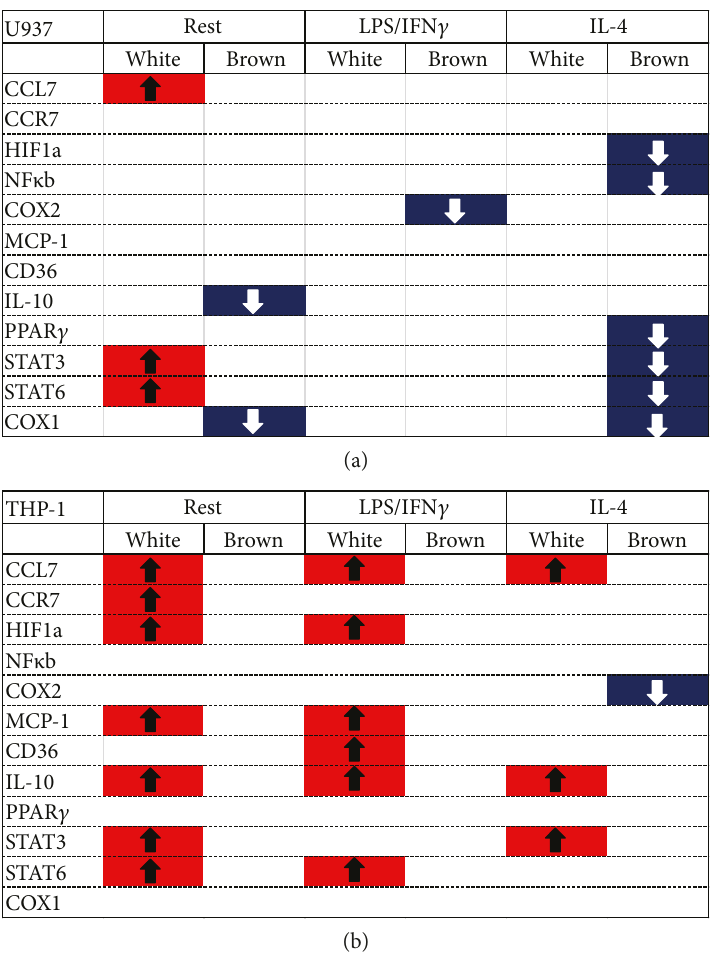
Figure 4: Summary of statistical analysis of transcript expression in macrophages . Summary of data analysis from Figure 3, which highlights transcripts that show statistically signi fi cant upregulation (denoted in red with up arrows) and transcripts that are signi fi cantly downregulated (denoted in blue with down arrows) in U937 macrophages (a) and THP-1 macrophages (b) when compared to monocultures of a similar stimulation state. Data were analyzed by two-way ANOVA followed by Tukey ’ s post hoc for multiple